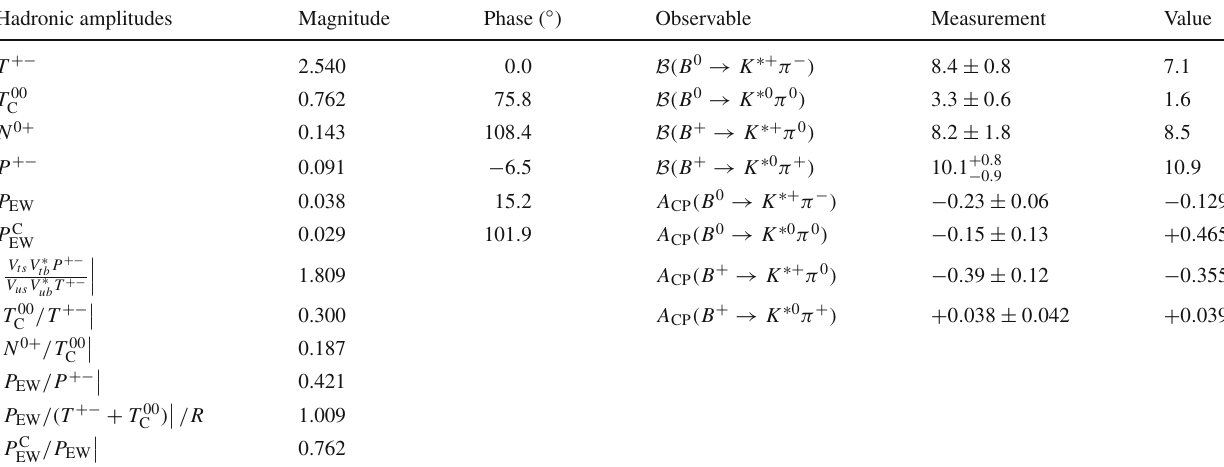
Table 11 Values chosen for our reference scenario. The values on hadronic parameters (left columns) are chosen to roughly reproduce the reference values of branching fractions (in units of 10 − 6 ) and CP asymmetries in B → K ∗ π (right columns). The reference input values